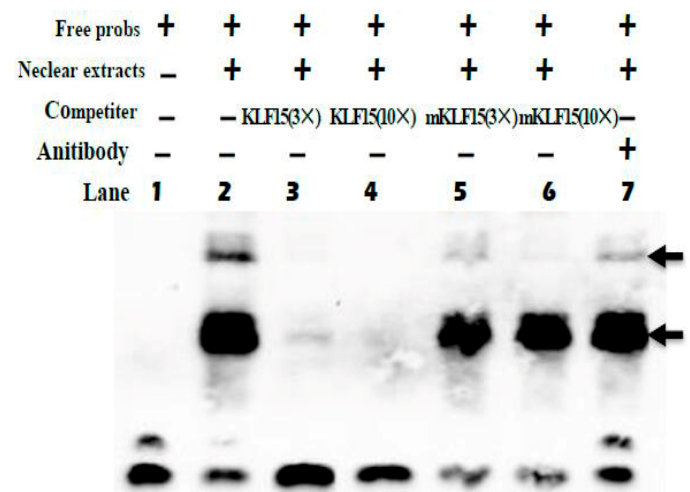
Figure 6. EMSA of KLF15 binding to the SLC27A1 promoter. Arrows denote primary complexes. KLF15 probes were combined with nuclear extracts as well as 3× unlabeled probe (lane 3), 10× unlabeled probe (lane 4), 3× mutated probe (lane 5), 10× mutated probe (lane 6), or no competition (lane 2). Super-shifting was assessed by addition of 10 ng anti-KLF15 (lane 7).